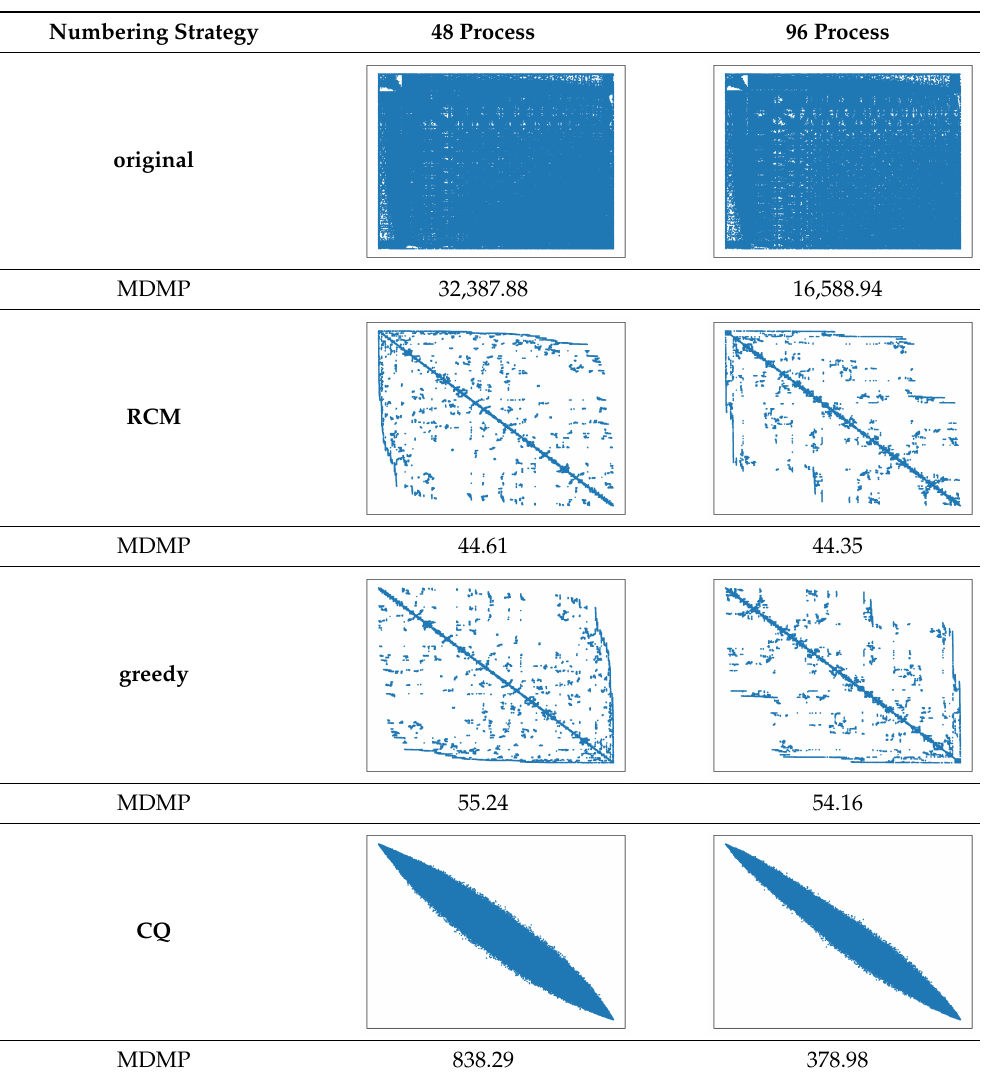
Table 2. The sparse matrix of the grid after being processed by different renumbering algorithms. The blue dots indicate the non-zero elements in the